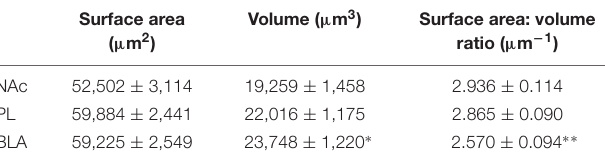
TABLE 1 | Regional heterogeneity of GFAP-positive